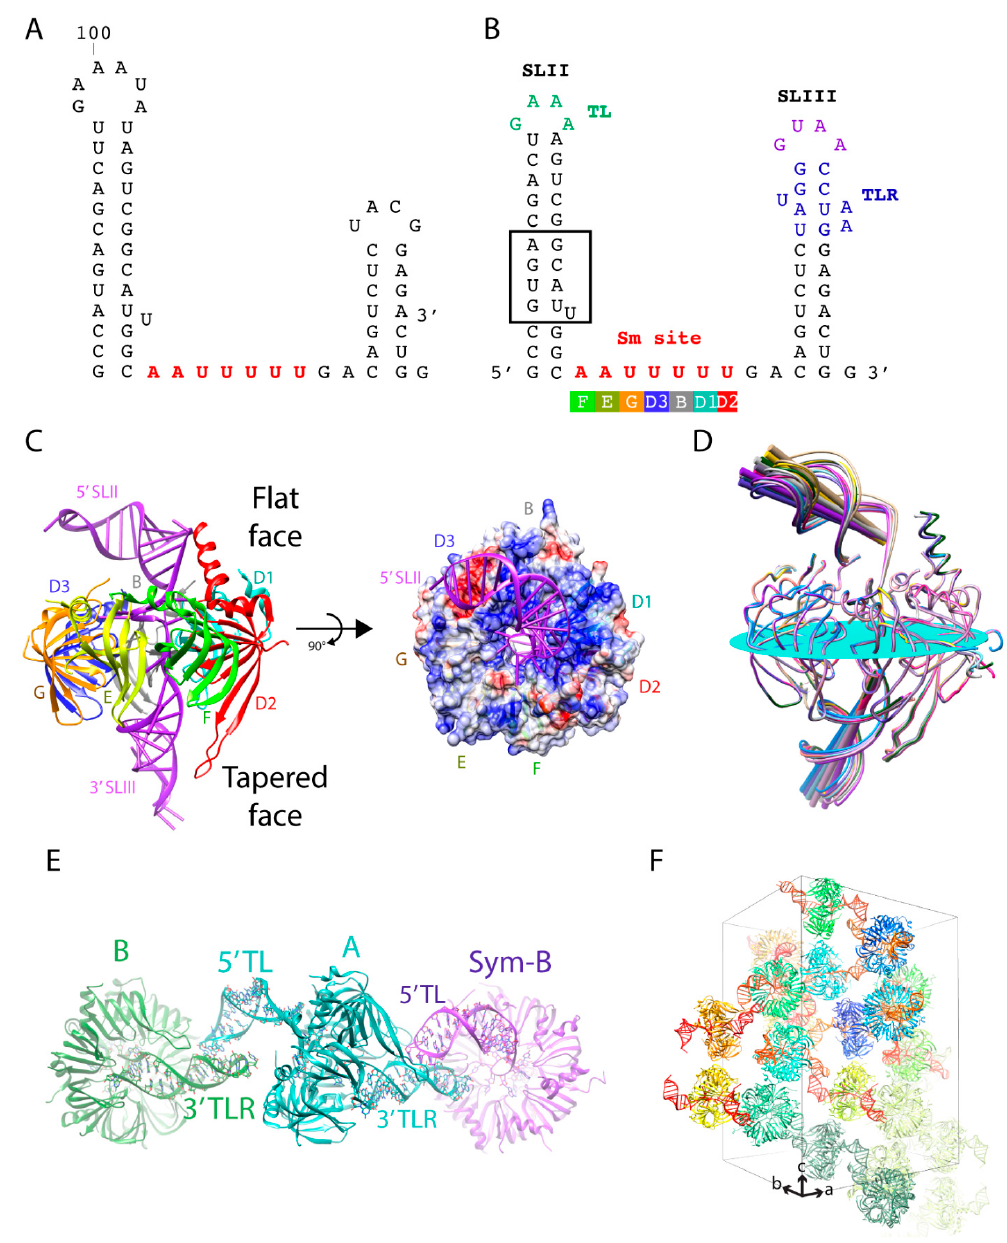
Figure 3. ( A ) Native sequence of the 3 ′ end of the U4 snRNA. ( B ) U4 construct used in the crystal structure. Highlighted in green is the GAAA tetraloop (TL), in purple is another stable GRNA tetraloop, and in blue is the GAAA receptor (TLR). The Sm site nucleotides that interact around the inner pore of the core ring is highlighted in red. Each Sm site nucleotide interacts in the binding pocket of the Sm protein depicted underneath. ( C ) One complex of the U4 snRNP core domain. The 5 (cid:48) SLII carrying the GAAA tetraloop is located on the flat face of the core ring and the 3 (cid:48) SLIII carrying the TLR is located on the tapered face of the core ring. The 5 (cid:48) SLII bends over the D2/D1/B sector of the ring. The surface color represents the electric potential of the surface (blue: positive, red: negative). ( D ) Superposition of the 12 NCS copies showing the stem loops have variable tilt angles relative to the plane of the core ring. The plane and the axes were drawn using Chimera. The plane was drawn by selecting the first residue after helix 1 of each Sm-fold. The orientation of the superposition is adjusted slightly from that shown in Figure A to better highlight the tilt angles of the RNA stems. ( E ) One example of the TL/TLR interactions between symmetry pairs. Twelve complexes packed as six distinct pairs are in the asymmetric unit. On the flat face, the 5 (cid:48) TL of complex A interacts with the 3 (cid:48) TLR of the NCS complex B. On the tapered face, the 3 (cid:48) TLR of complex A interacts with another complex B related by crystallographic symmetry. ( F ) The TL/TLR interactions combines the core rings to pack rim-to-rim along the c